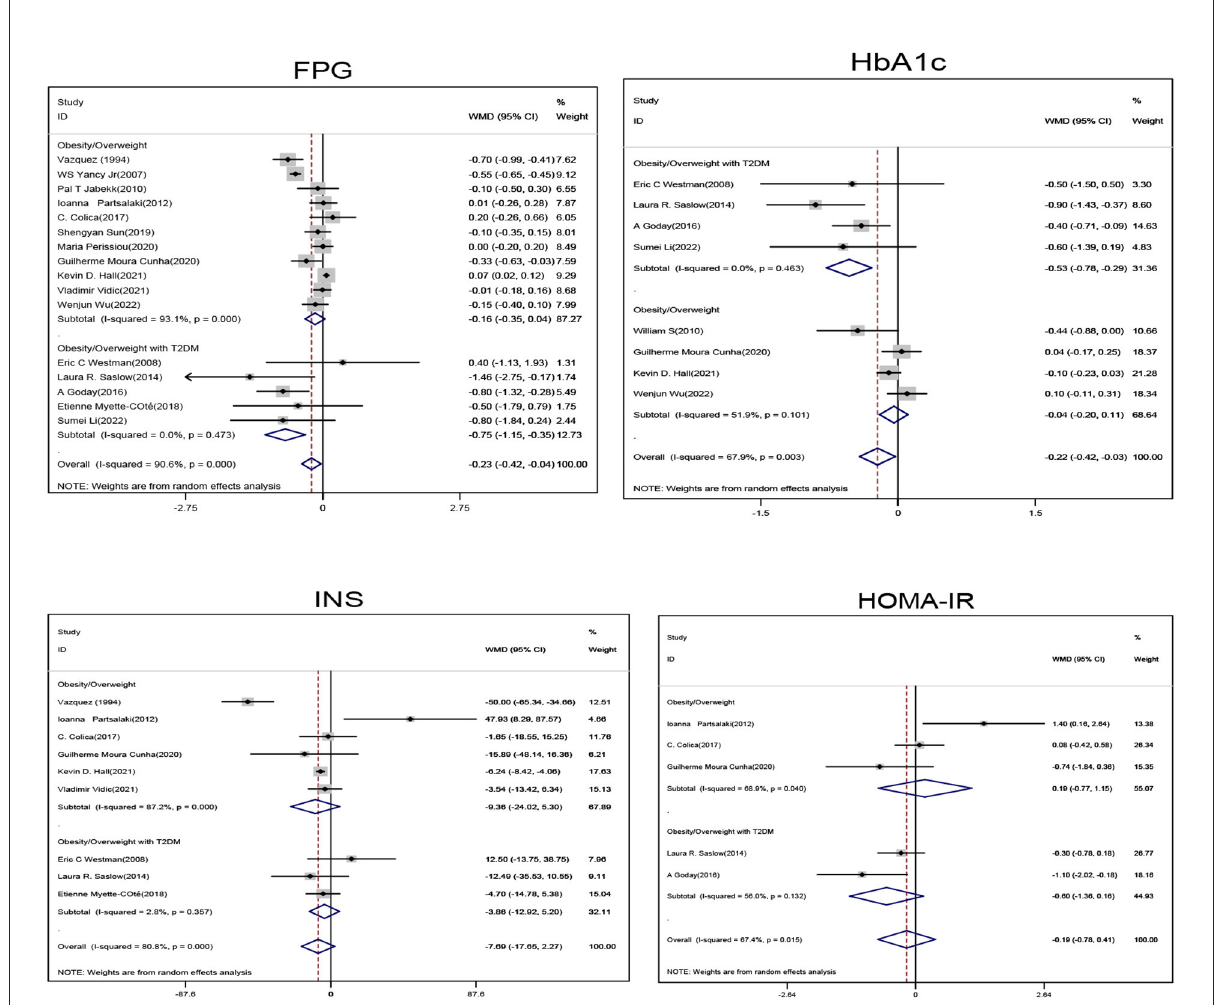
FIGURE1 Forest plot showing weighted mean difference and 95% confidence intervals (CIs) for low carbohydrate ketogenic diet effects on glucose metabolism. FPG, Fasting blood glucose; HbA1c, Glycosylated hemoglobin; INS, Insulin; HOMA-IR, Homeostatic model assessment.